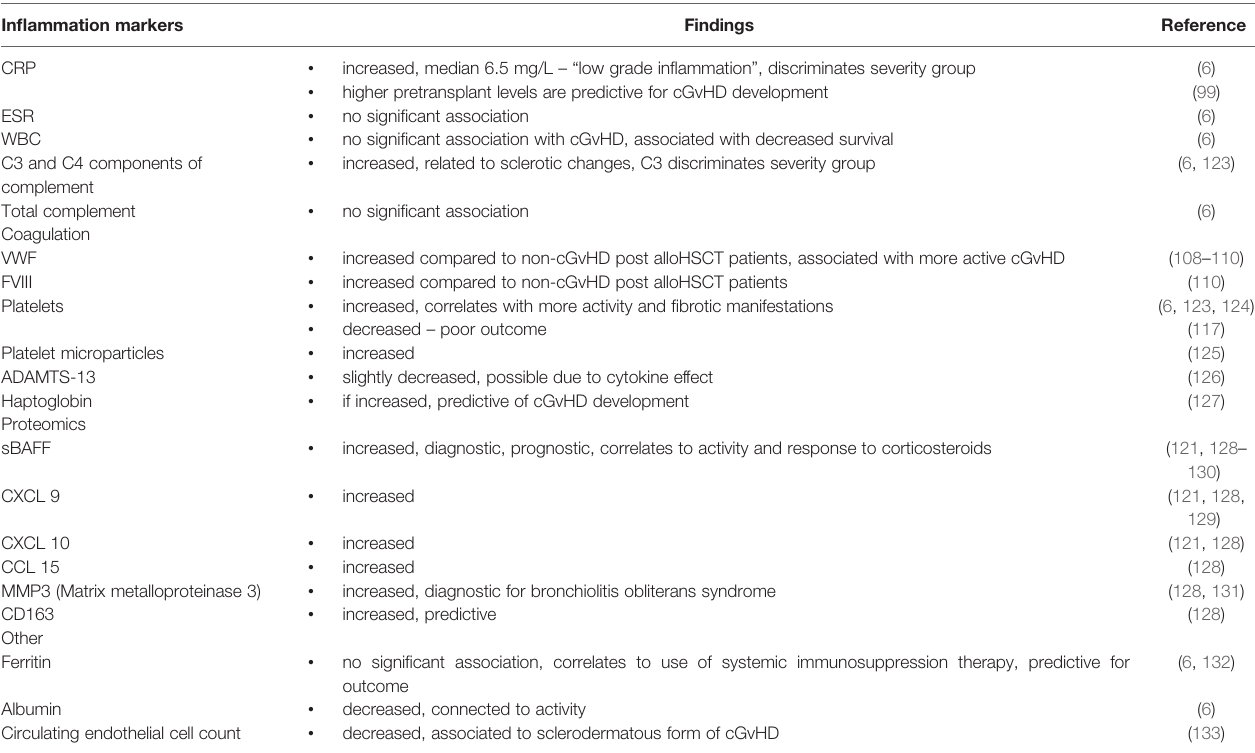
cGvHD, chronic graft-versus-host disease; CRP, c-reactive protein; ESR, erythrocyte sedimentation rate; WBC, white blood cells count; VWF, von Willebrand factor; FVIII, factor VIII; ADAMTs-19, a disintegrin and metalloproteinase with a thrombospondin type 1 motif, member 13; sBAFF, soluble B-cell activating factor; CXCL 9, chemokine (C-X-C motif) ligand